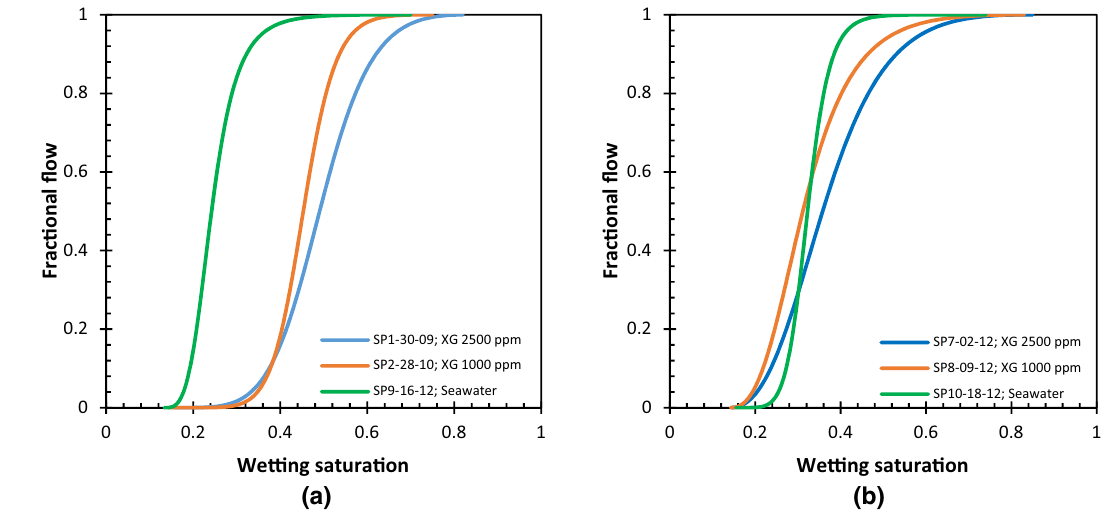
Fig. 12 Fractional flow curves based upon experimental data for different sandpacks a motor oil and b heavy oil